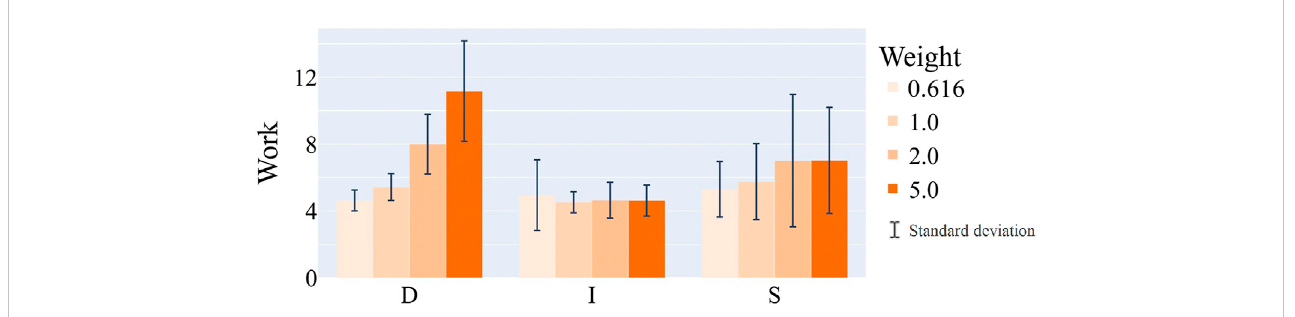
FIGURE 7 Mean ± SD of work for 20 users for the VR (non-haptic) conditions. From left to right: D = direct weight condition, I=Isomorphic condition, S = speed control